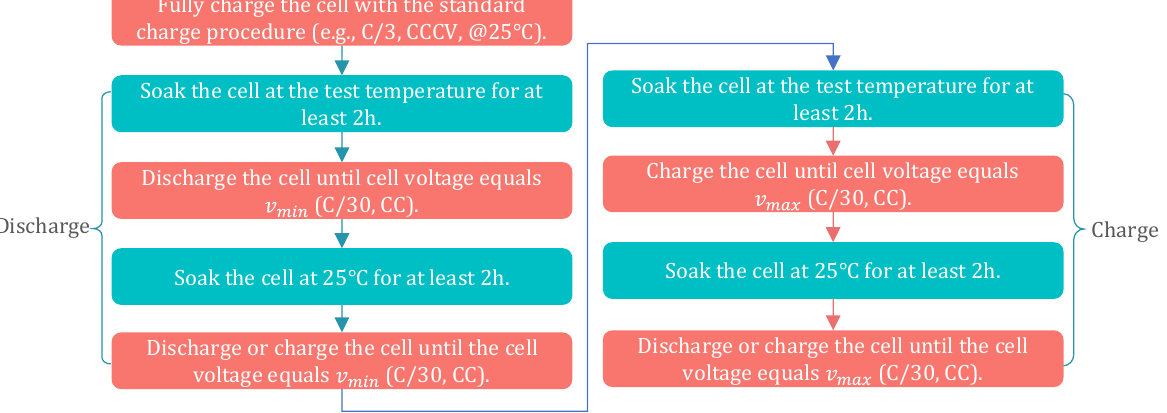
Figure 5. OCV test procedure. CCCV refers to constant current and constant voltage charge strategy. CC stands for constant current charge